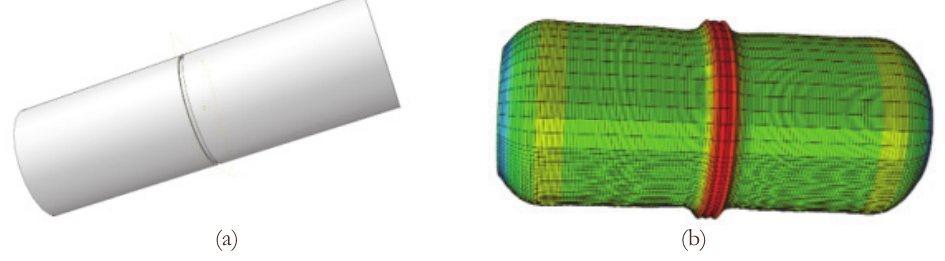
Figure 2: Notched cylinder (a) FEA of notched cylinder (b).